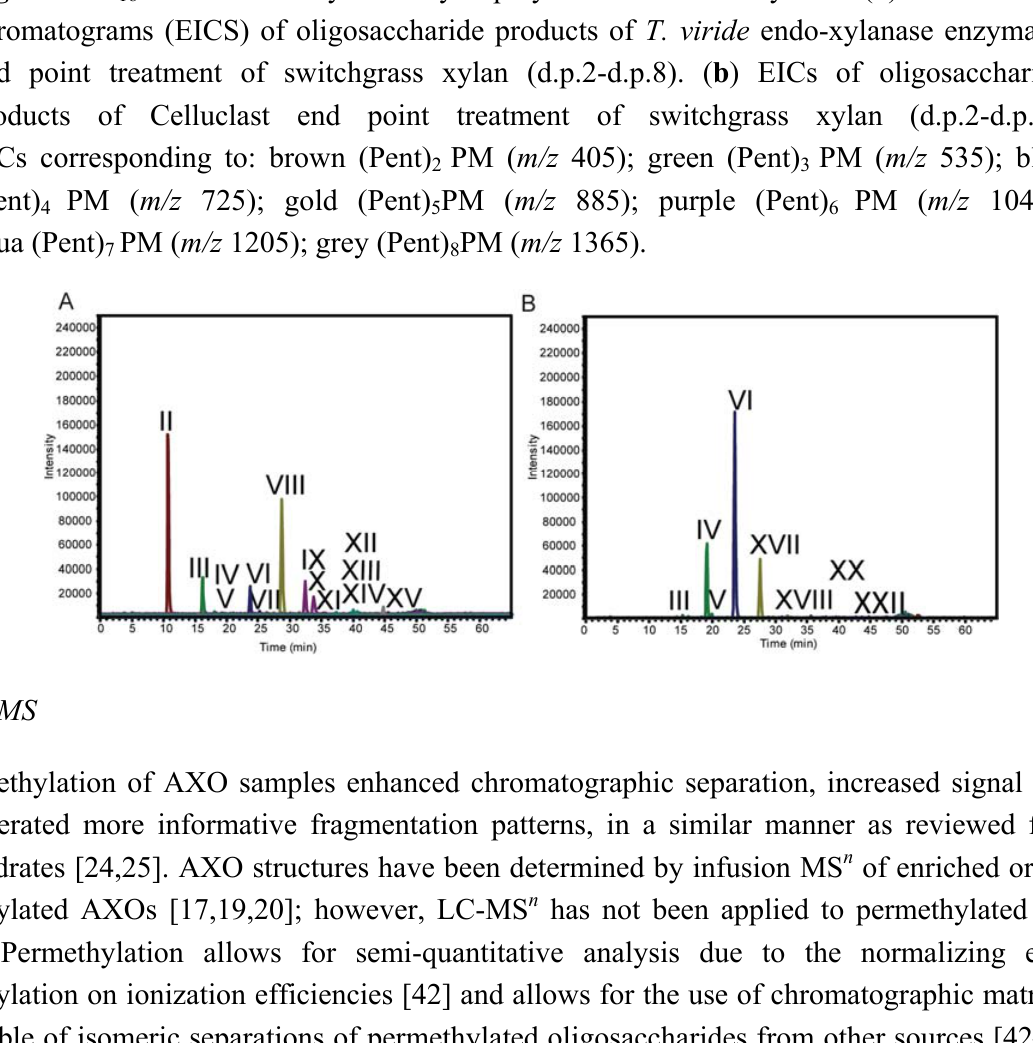
Figure 1. C -LC-MS of enzymatically depolymerized MPV-2 xylan B ( a ) extracted-ion 18 chromatograms (EICS) of oligosaccharide products of T. viride endo-xylanase enzymatic end point treatment of switchgrass xylan (d.p.2-d.p.8). ( b ) EICs of